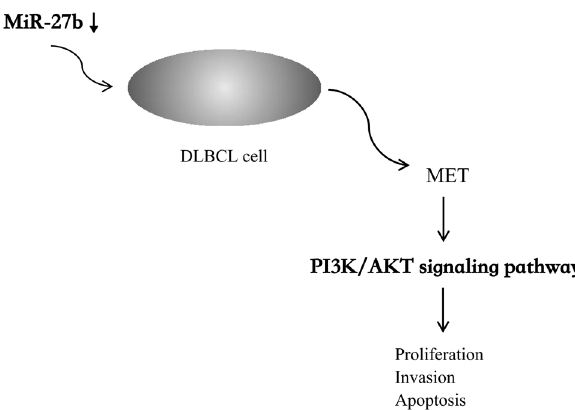
Fig. 7 Schematic diagram of miR-27b regulating MET/PI3K/ AKT signaling